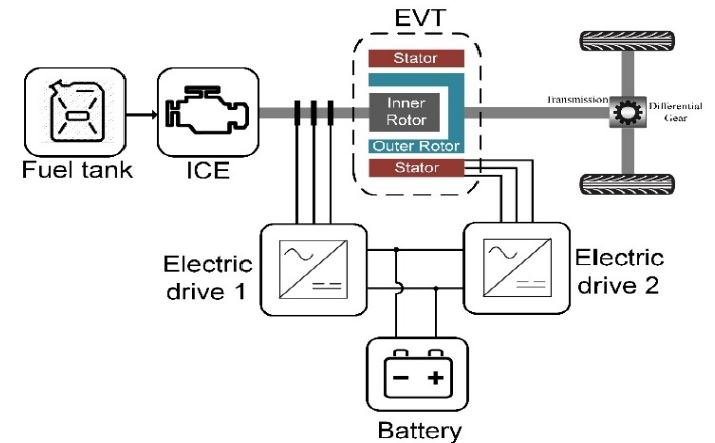
Figure 2. Hybrid electric vehicles (HEV) equipped with EVT topology.